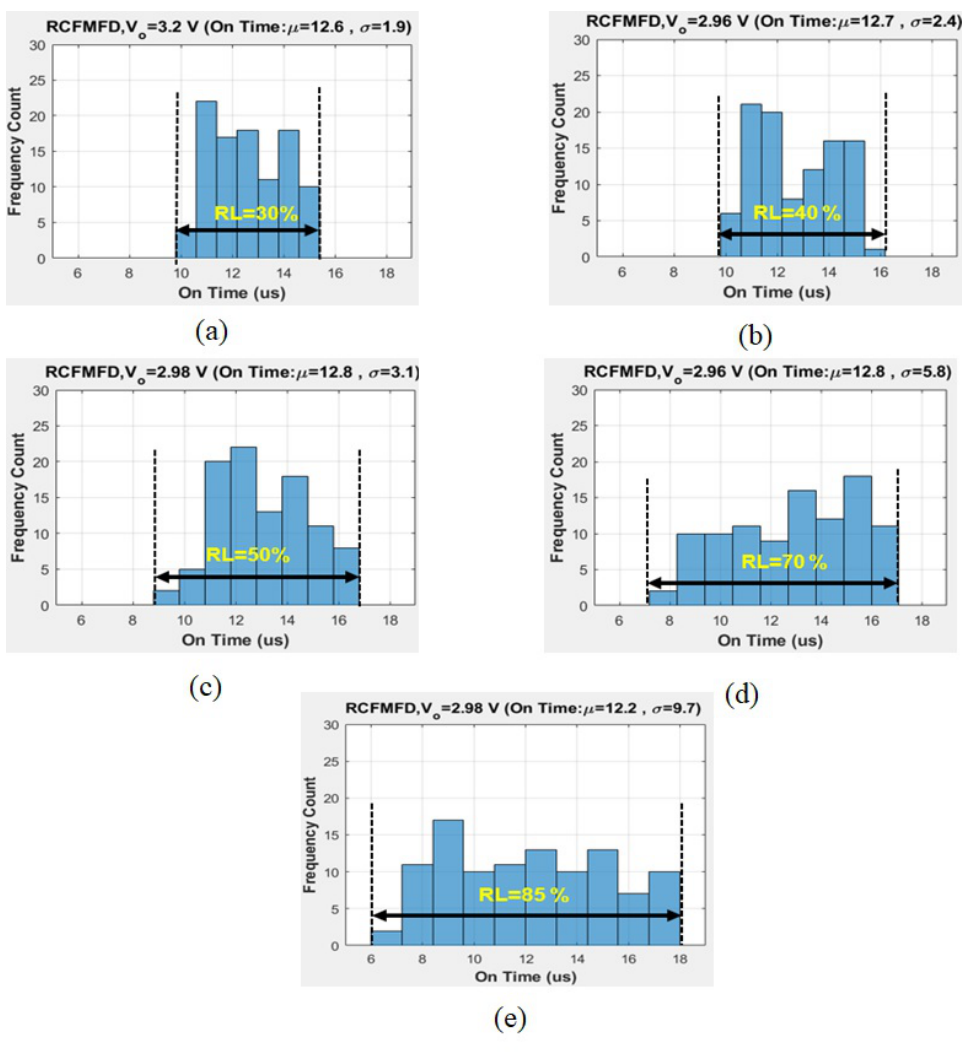
Figure 19. Comparison of the histograms of the switch 1 switching signal for various randomness levels (RL) of RCFMFD for an interleaved converter ( a ) 30% RL, ( b ) 40% RL ( c ) 50% RL, ( d ) 70% RL, and ( e ) 85%